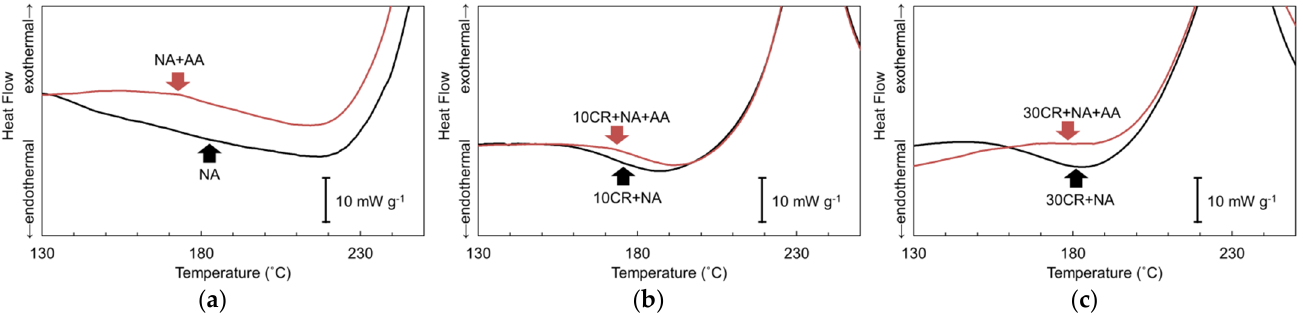
Figure 6. Enlarged cluster dissolution peaks of DSC curves in ( a ) NA and NA + AA for 0.3 ks samples, ( b ) 10CR + NA and 10CR + NA + AA for 0.3 ks samples and ( c ) 30CR + NA and 30CR + NA + AA for 0.3 ks samples. Table 2. Amount of endothermal heat by cluster dissolution in NA, 10CR + NA and 30CR + NA samples without artificial aging (AA) or with AA for 0.3 ks (J/g).